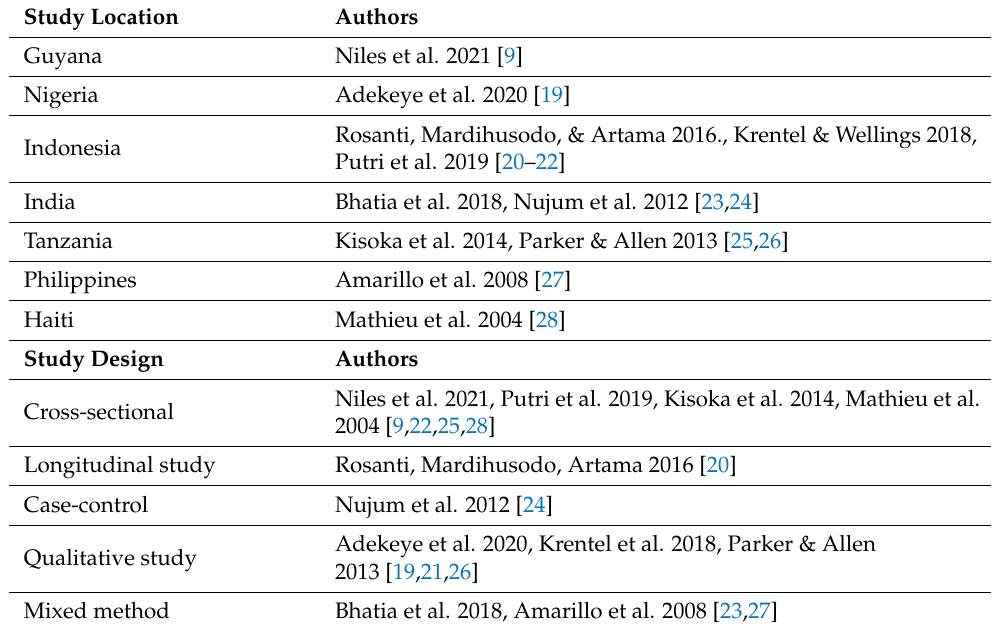
Figure 1. PRISMA flow diagram for the systematic review. Table 1. Summary of study location and study